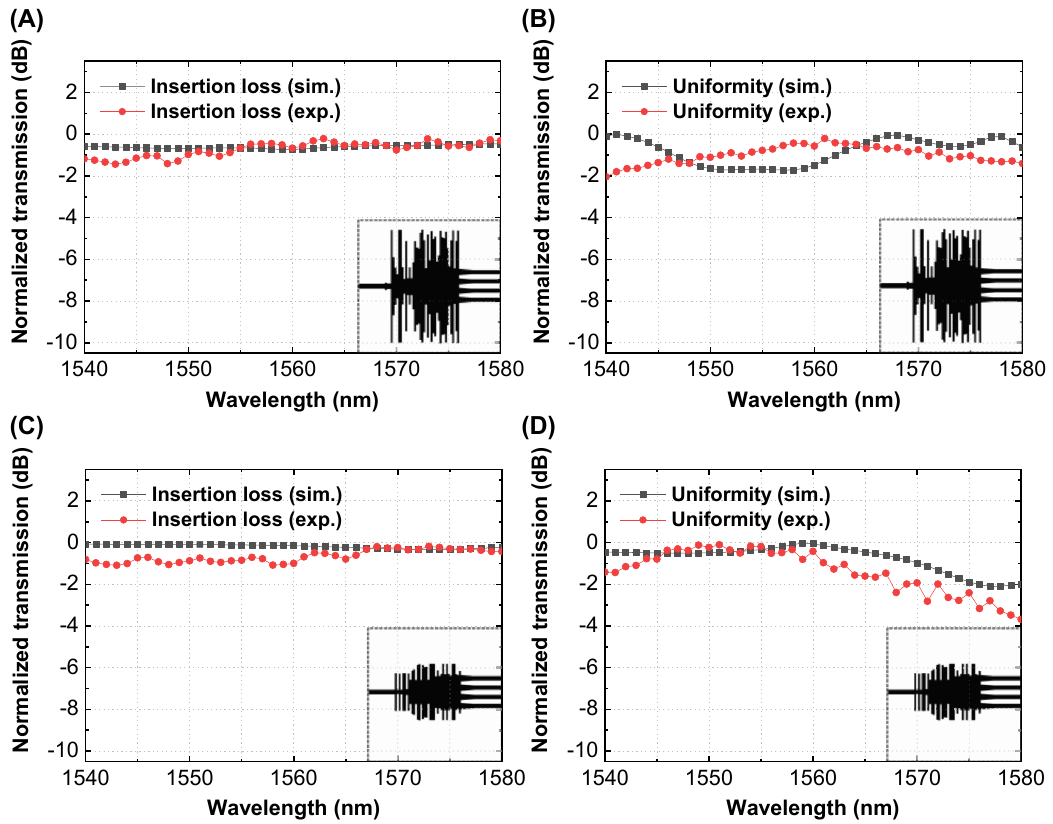
Figure 6: Comparison between simulation results and experimental results for the OPS 1 (A) insertion loss, (B) uniformity loss, and OPS 2 (C) insertion loss, and (D) uniformity